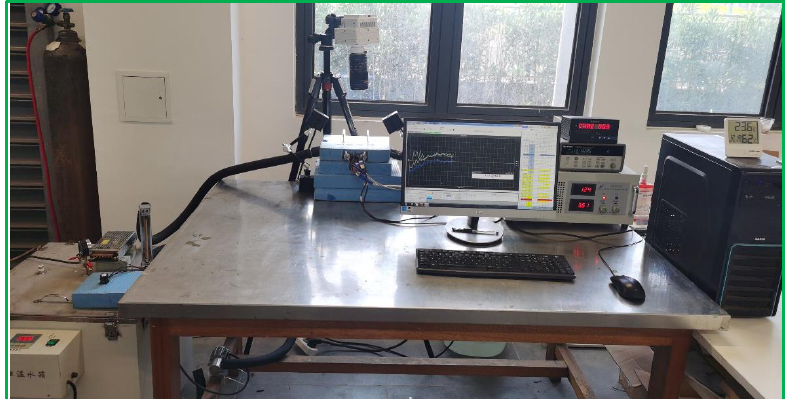
Figure 2. Schematic diagram of experimental setup.